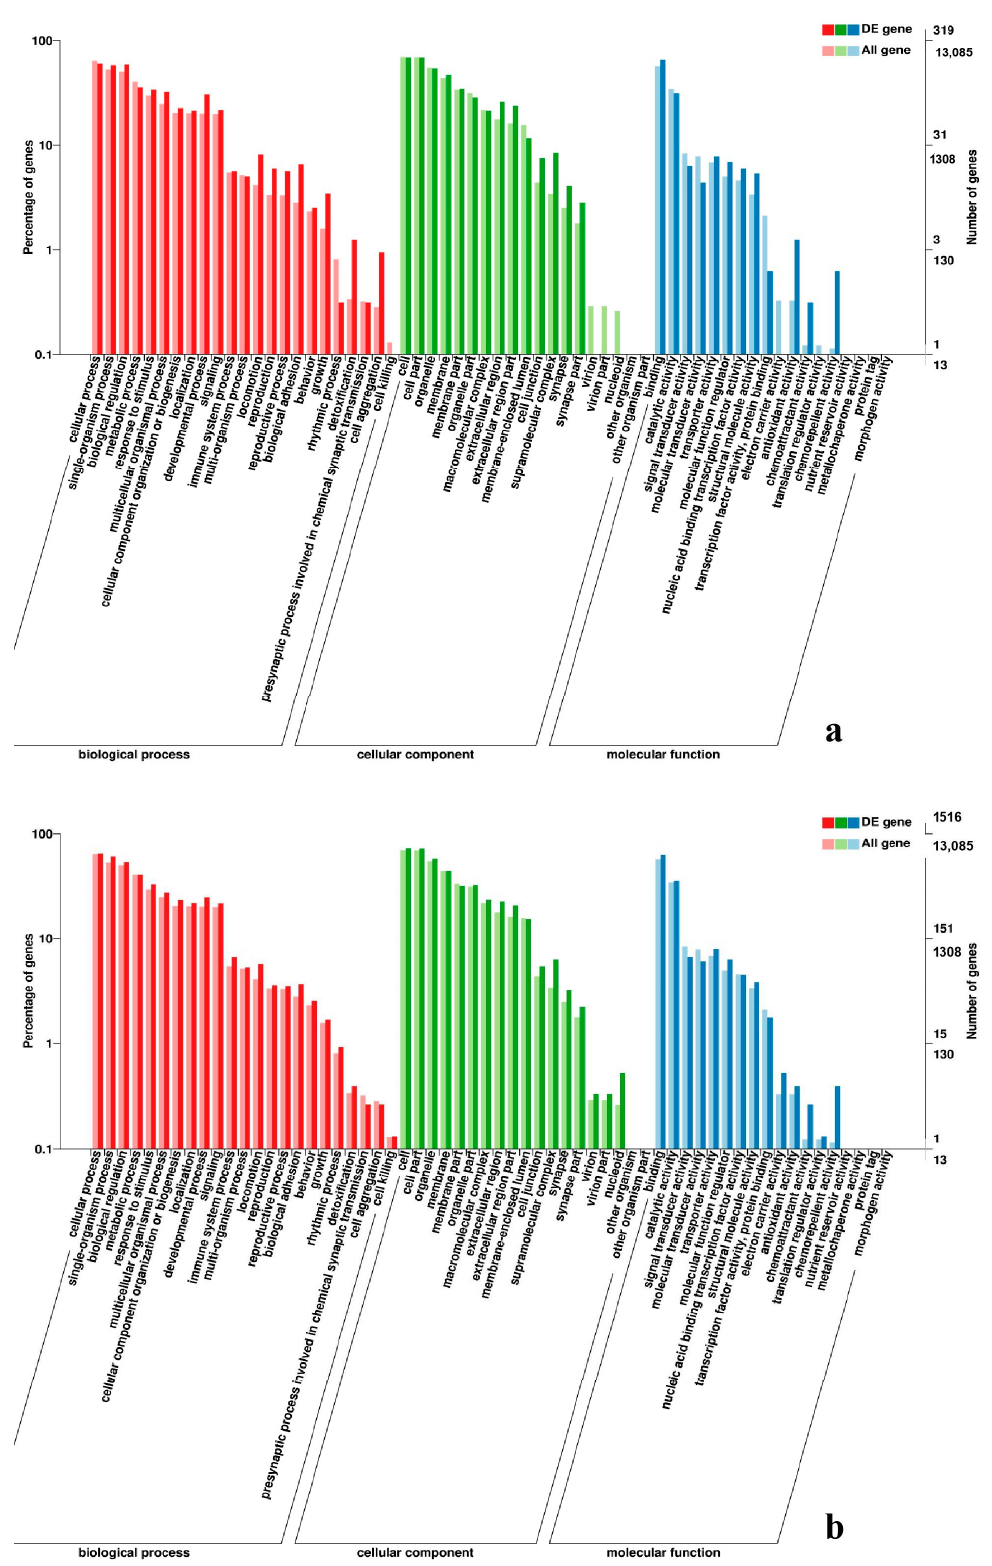
Figure 3. GO enrichment analysis of di ff erentially expressed genes (DEGs) in breast 3